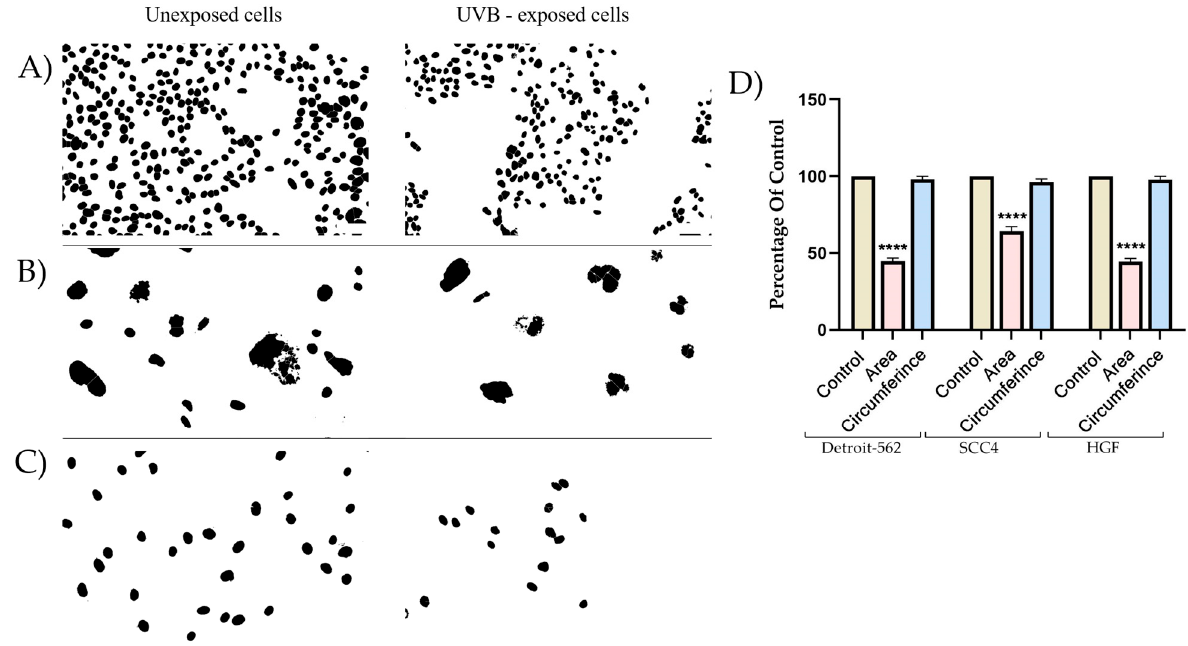
Figure 8. Evaluation of cell nuclei of the ( A ) Detroit-562, ( B ) SCC4, and ( C ) HGF cells, after conversion to 8-bit images and the application of the make-binary function. ( D ) As compared to the control cells, the cells exposed to UVB (5 J/cm 2 ) showed a decrease in their nuclear area as well as their nuclear circumference. The statistical differences between control and exposure cells were verified by applying a one-way ANOVA analysis, followed by Dunnett’s multiple comparison post hoc test (**** p < 0.0001).